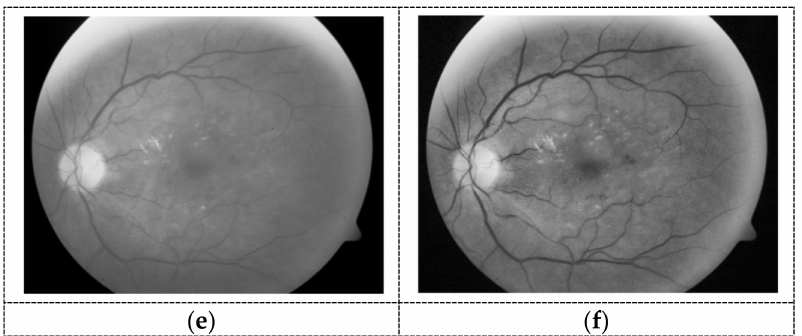
Figure 8. Results of pre-processing algorithm ( a ) original image, ( b ) HE, ( c ) AGCWD, ( d ) BPDFHE, ( e ) NMHE, ( f )